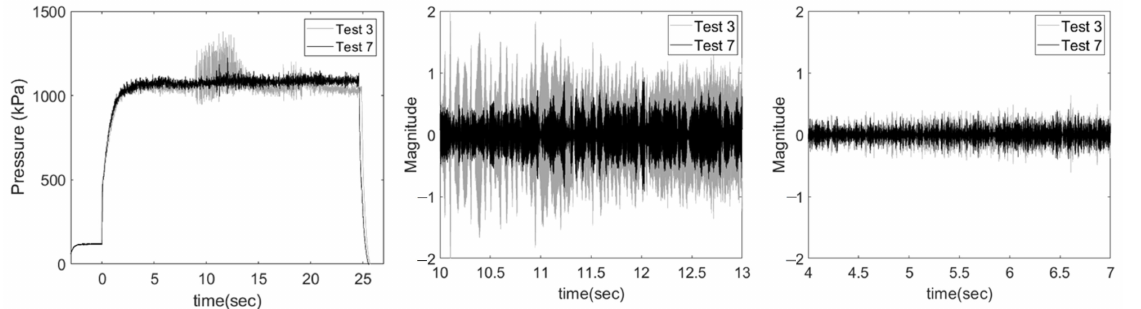
Figure 12. Overlays of combustion pressure and filtered pressure in tests 3 and 7.